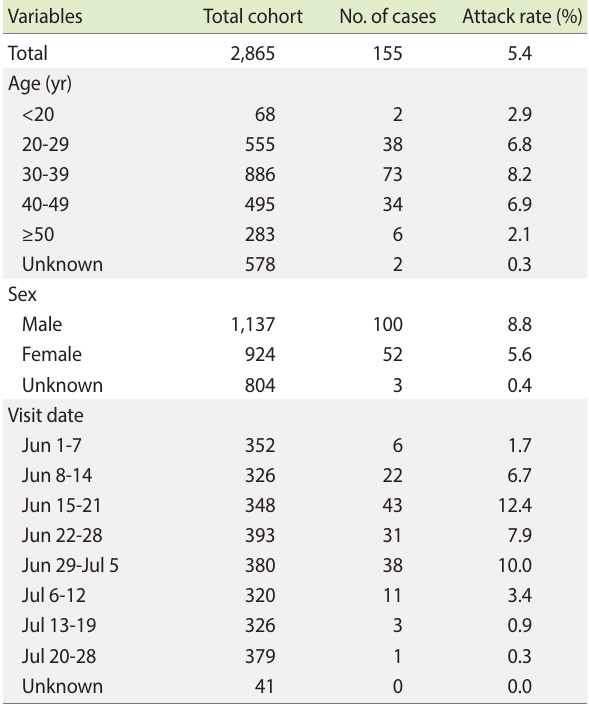
Table 1. Attack rate by age group, sex, and visit date